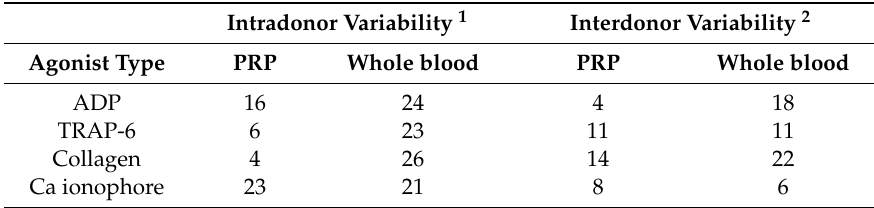
Table 1. Precision of the MICELI aggregometer using di ff erent platelet agonists as indicated by intra- and interdonor variability of area under the curve (CV,